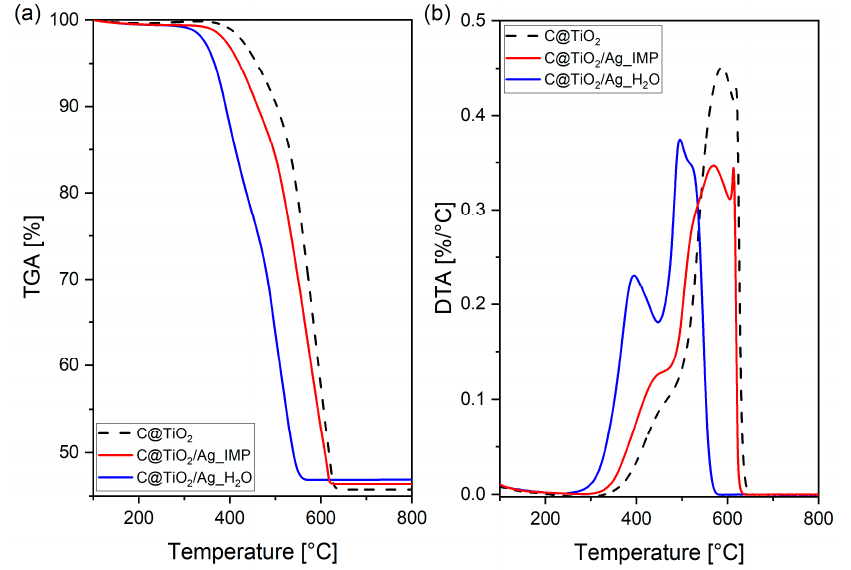
Figure 2. TGA ( a ) and DTA ( b ) analyses of the C@TiO 2 composite at oxidizing atmosphere before and after deposition of Ag using two di ff erent methods—IMP and H 2 O. and after deposition of Ag using two different methods—IMP and H 2